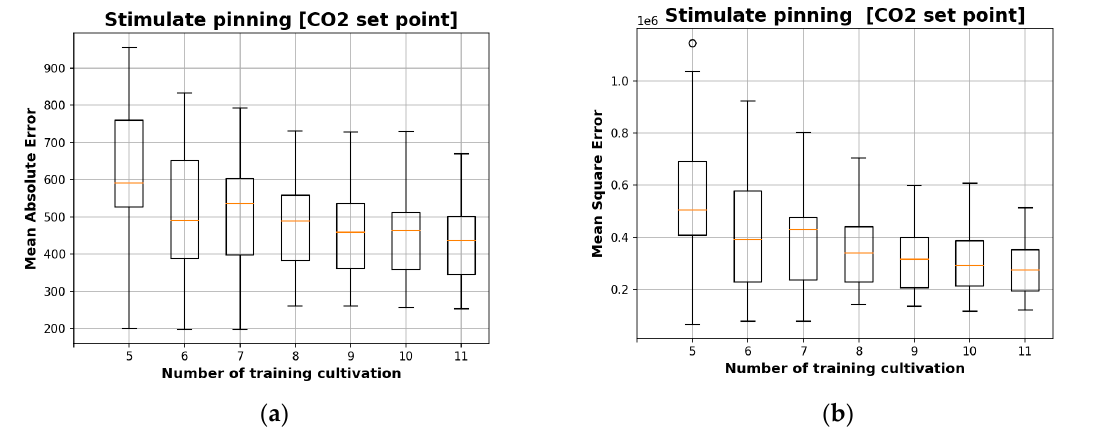
Figure 16. Boxplots of mean square error ( a ) and mean absolute error ( b ) of the cross-validation results for choosing change value of CO 2 set point in the fruiting stage to stimulate pinning.